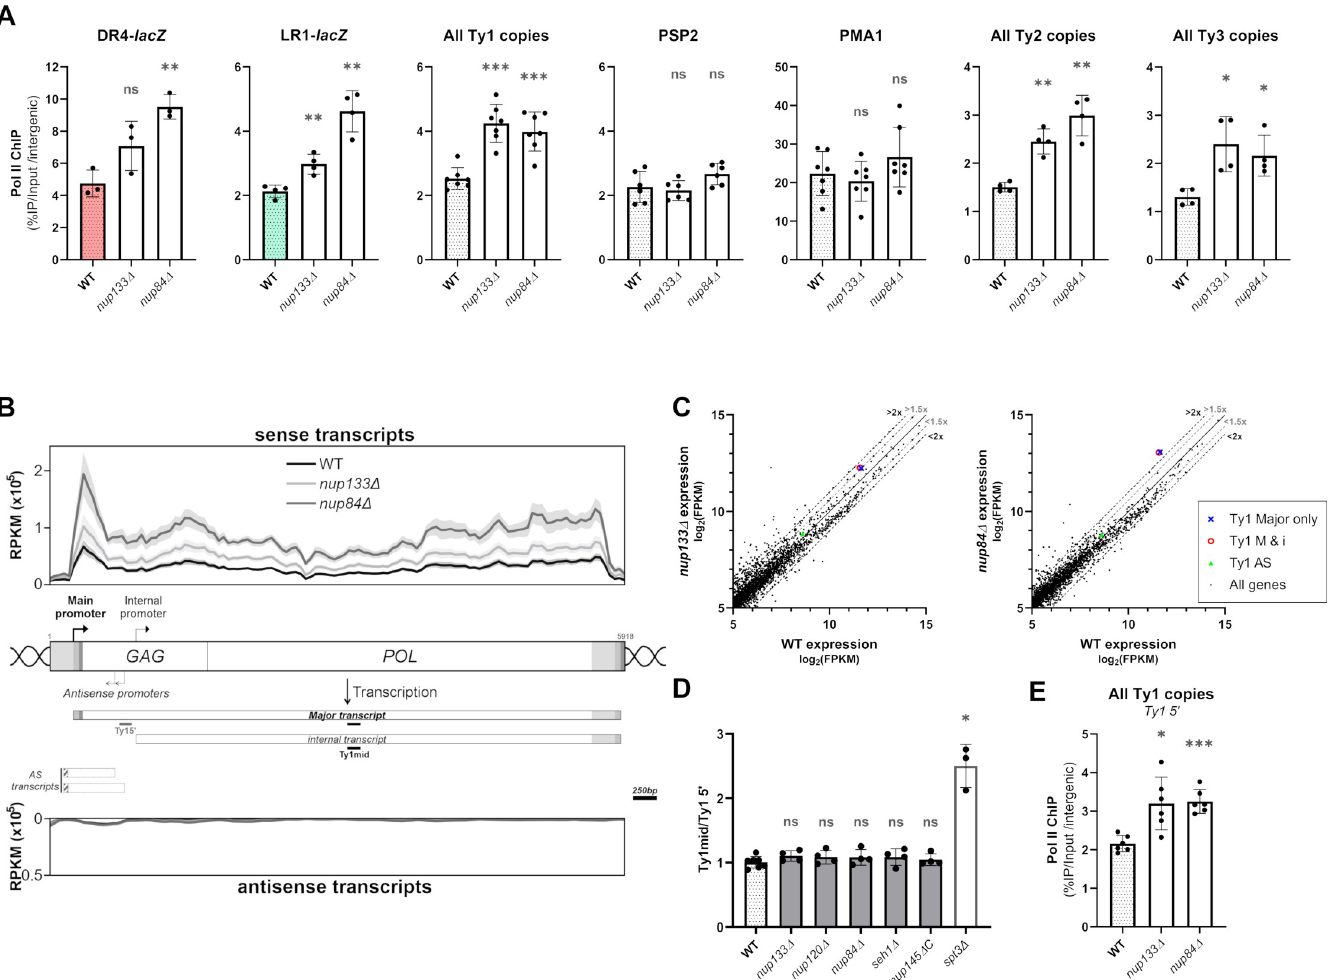
Fig 2. The Nup84 complex regulates the expression of LTR-retrotransposons at the transcriptional level. (A) RNAP II occupancy on the DR4 and LR1 Ty1- lacZ fusions, all Ty1 genomic copies, PMA1 or PSP2 loci, and all Ty2 and Ty3 genomic copies, as determined by ChIP in WT, nup133 Δ and nup84 Δ cells. Values (mean ± SD, n � 3) are expressed as a percentage of IP and normalized to an intergenic region. (B) Upper and lower panels : Metagene analysis showing Ty1 RNA-seq sense and antisense read counts in WT, nup133 Δ and nup84 Δ cells, averaged over all 32 genomic Ty1 elements and represented as reads per kb per million (RPKM; mean ± standard error, n = 3). Mid panel : Ty1 locus organization and expression. Long Terminal Repeats (LTR) flank two overlapping ORFs ( GAG and POL ). The 5.7 kb Ty1 major transcript starts at the U3/R junction of the 5 0 LTR and ends at the R/U5 junction of the 3 0 LTR (U3, R and U5 regions are indicated from light grey to dark grey). The 5 kb internal Ty1 RNA species is transcribed from an internal promoter located around 800bp downstream of the main promoter. Major antisense (AS) noncoding RNAs starting from two distinct promoters are depicted, with their reported heterogenous 3’ ends represented as shaded boxes (according to [109,110]).The position of the qPCR amplicons used in (D) are shown, the Ty1mid amplicon being used for RT-qPCR measurement of Ty1 RNA levels in all the figures except Fig 2D and 2E. Scale bar, 250bp. (C) Scatterplots showing expression levels of cellular RNAs in nup133 Δ ( left ) or nup84 Δ ( right ) mutants vs WT strains as described in Fig 1B. Expression of Ty1 based on reads either uniquely assigned to major transcripts ( blue cross ) or assigned to both major and internal transcripts ( red circle ) is specified. The abundance of antisense Ty1 RNAs is also highlighted ( green triangle ). (D) Ty1 RNA levels in WT cells and non-essential mutants of the Nup84 complex, as measured by RT-qPCR using Ty1 5’ and Ty1mid amplicons, which hybridize only with major transcripts and all sense transcripts, respectively. The ratio of values obtained with Ty1mid and Ty1 5’ is represented (mean ± SD, n � 3). The spt3 Δ mutant is used as a positive control for induction of the internal promoter and specific increase of internal transcripts. (E) RNAP II occupancy at the 5’ end of Ty1 genomic copies determined by ChIP using the Ty1 5’ amplicon in WT, nup133 Δ and nup84 Δ cells. Values (mean ± SD, n � 3) are expressed as a percentage of IP and normalized to an intergenic region. ns, not significant; � p < 0.05; �� p < 0.01; ��� p < 0.001, Welch’s t test with comparison to the WT